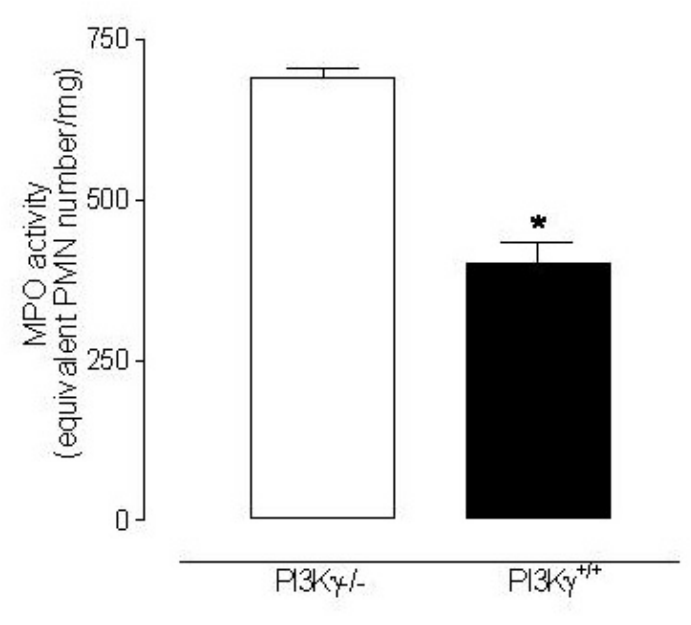
Figure 2. The absence of PI3K γ exacerbates the PMN influx into the myocardium. Myocardial myeloperoxidase activity (MPO, index of PMN tissue infiltration) in infarcted hearts of PI3K γ +/+ and PI3K γ -/- mice was measured according to the method previously described [ 25 ] . Briefly, the area at risk was homogenized in Tris- buffer containing proteinase inhibitors and the homogenates were centrifuged for 30 min at 4,000 x g at 4°C. Aliquot (20 µl) of the supernatant was then allowed to react with a solution of tetra- methyl-benzidine (1.6 mM) and 0.1 mM H 2 O 2 . The rate of change in absorbance was measured with a spectrophotometer at 620 nm. A standard curve was constructed with different numbers of mice neutrophils that were elicited into the peritoneal cavity at 4 h in response to application of 1 ml thioglycollate [ 25 ] . Pellets were subjected to three cycles of freeze thawing. Samples (100 µl) were obtained after a final centrifugation at 13,000 r.p.m. for 30 min on a benchfuge. The MPO reaction was produced with a PMN number ranging from 0 to 225 x10 3 , obtaining a linear relationship with the absorbance at 620 nm following the equation: A 620 =4.504 x no. of PMN + 33.74, with a R 2 =0.97983. Data of MPO activity are reported as equivalent numbers of PMN per mg of tissue. Data are mean ± SE of n=10 mice per group.* P<0.01 vs. respective PI3K γ -/-